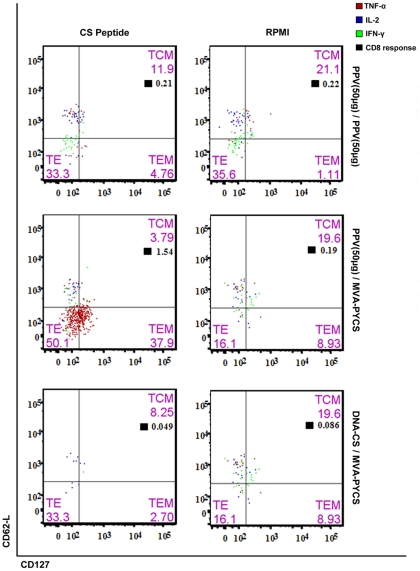
PPV-PYCS/MVA-PYCS prime/boost improves cytokine secretion by memory CD8+ T-cells.Groups of BALB/c mice (4 per group) were immunized in prime/boost as indicated in Table 1 and 53 days post boost splenocytes were processed for ICS as described under Materials and Methods. Phenotypic differentiation of CD8+ T-cells based on memory markers CD127 (V450) and CD62L (FITC). Each quadrant represents different memory population of CD8 cells with its respective percentages. The distribution of antigen specific CD8+ T-cells secreting cytokines in response to CS peptide stimulation, within the different memory population is also shown. The total CD8+ T-cell response is indicated by the black boxes. The boxes on left indicate the responses towards CS peptide stimulation while the ones on right represent its respective RPMI controls.